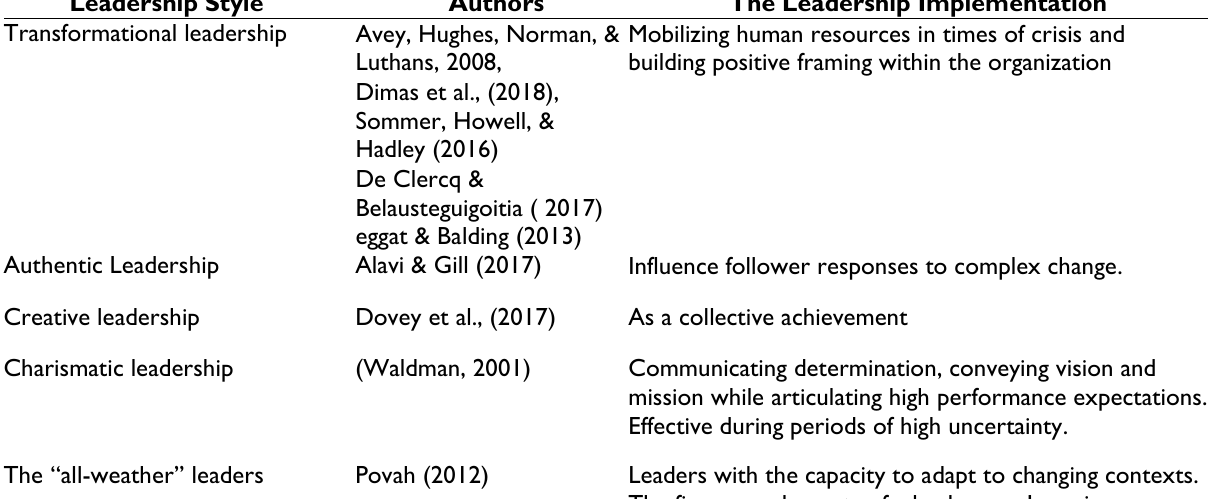
Table 6: Leadership Style in Crisis Leadership